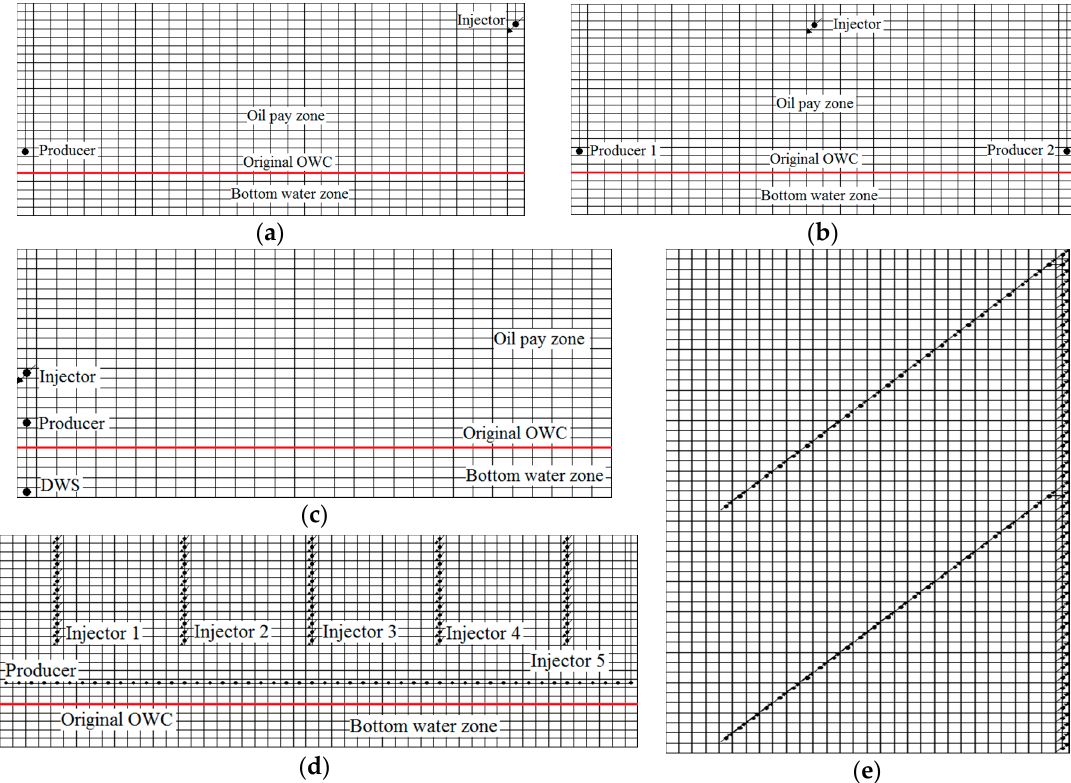
Figure 12. Well pattern structures for ( a ) two corner wells in the I-K direction cross-section; ( b ) triple wells in the I-K direction cross-section; ( c ) DWS in the I-K direction cross-section; ( d ) VInj-HPro, and ( e ) fishbone well in the I-J direction cross-section.